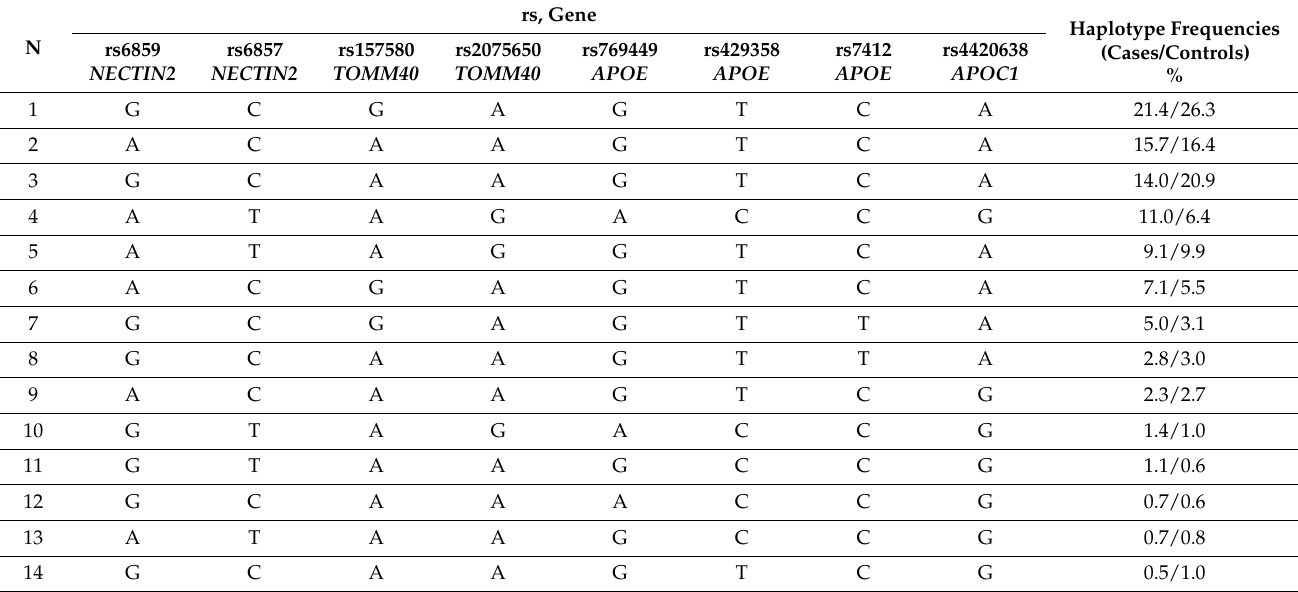
Table 4. Identical haplotypes identified in both groups.